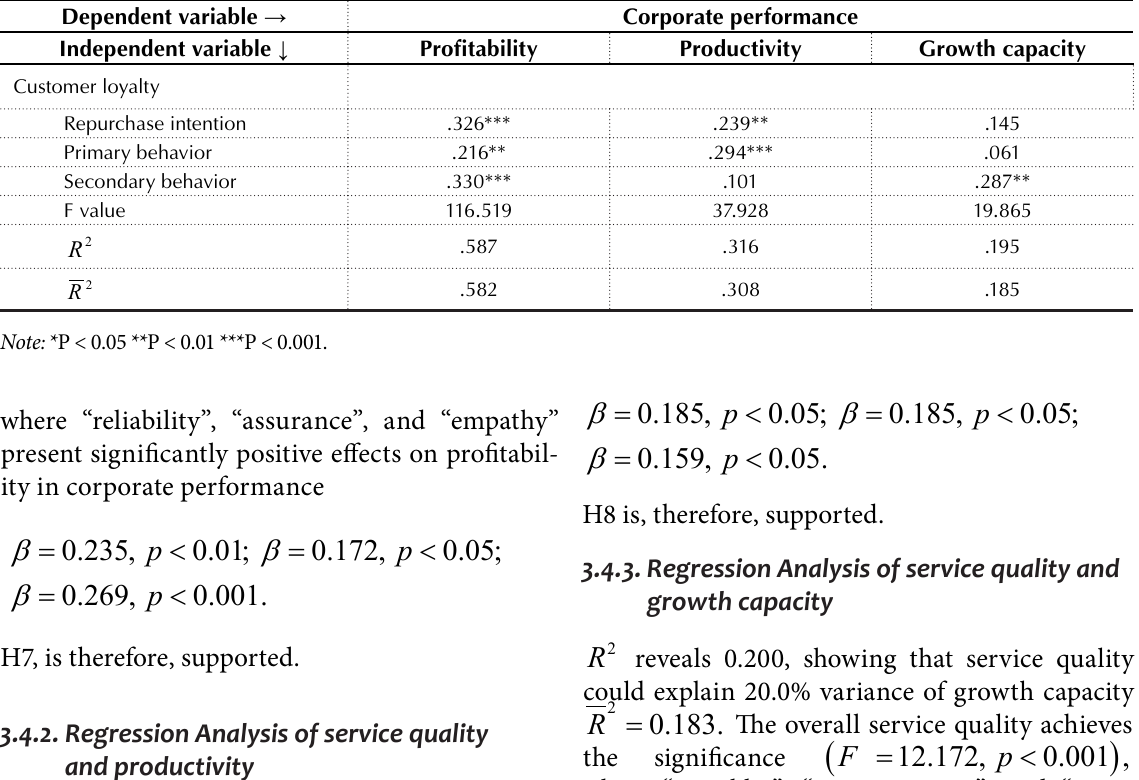
Table 2. Multiple Regression Analysis of customer loyalty and corporate performance